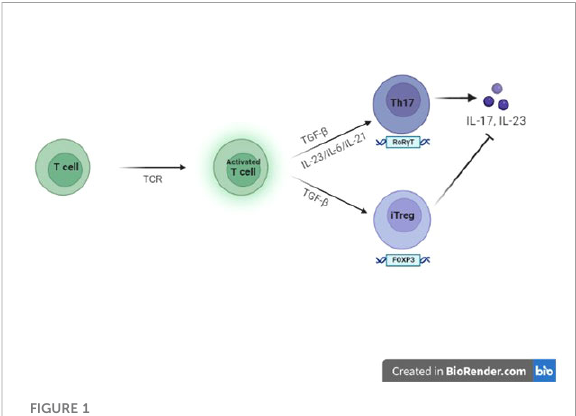
FIGURE 1 Role of FOXP3 on Tregs and Th17s In the context of an adequate pro-in fl ammatory microenvironment for speci fi c Interleukins, TGF- b , the cytokine-guide for the differentiation of iTregs (induced Tregs), promote the differentiation into